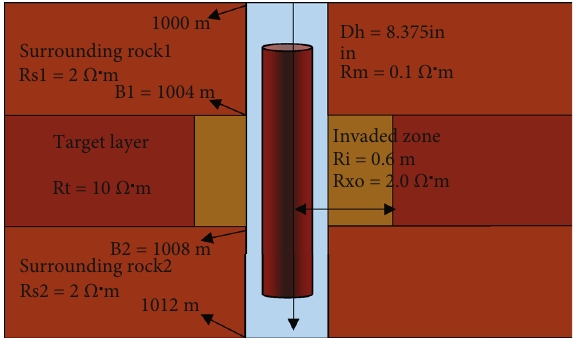
Figure 5: Schematic diagram of the time-lapse resistivity joint inversion formation